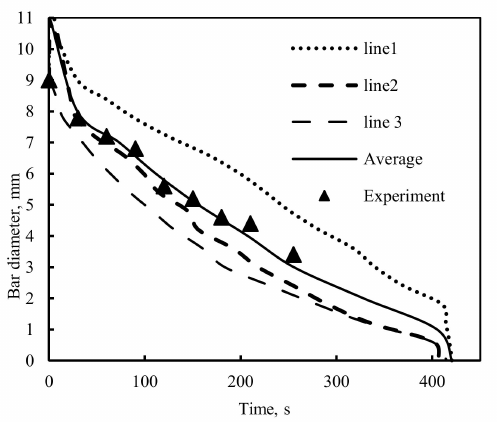
Figure 8. The changes of bar diameter at di ff erent monitor